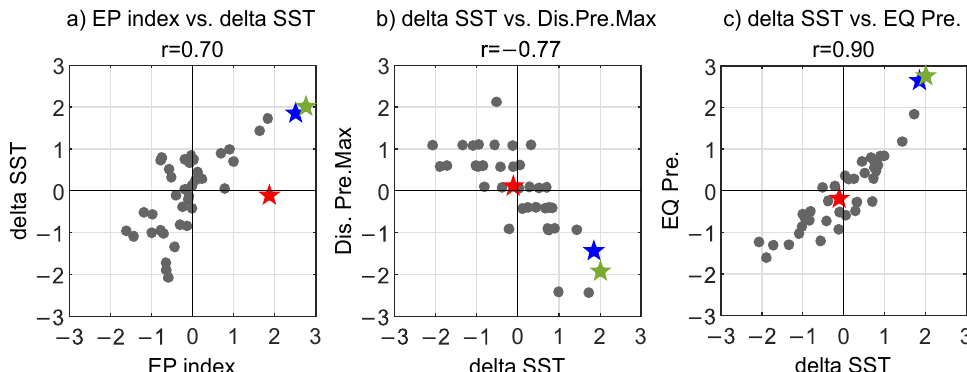
Figure 6. Scatter diagrams of ( a ) EP index (i.e., Niño 3 index) versus delta SST (i.e., SSTA EQ − 0.5* (SSTA SH +SSTA NH )); ( b ) delta SST versus change in distance between two ITCZs (i.e., anomalies for |Lat precip.max.NH − Lat precip.max.SH |); ( c ) delta SST versus equatorial precipitation for EP (i.e., PA EQ − 0.5* (PA SH +PA NH )). For each subfigure, solid stars denote the extreme El Niño decaying years: 1983 (blue), 1998 (green), and 2016 (red). All these indices are calculated for the season March-April and are normalized. In all subfigures, the correlations are statistically significant at a 99% confidence level.